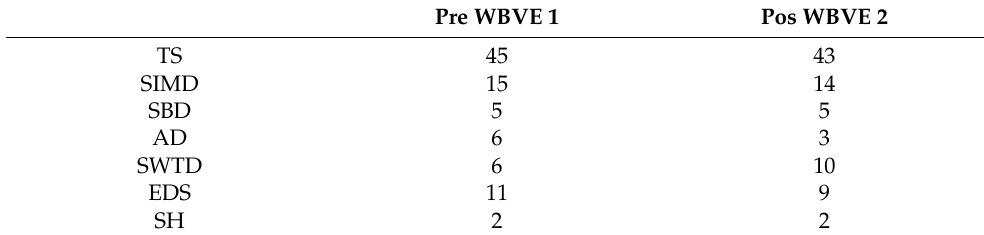
Table 6. WBVE results in